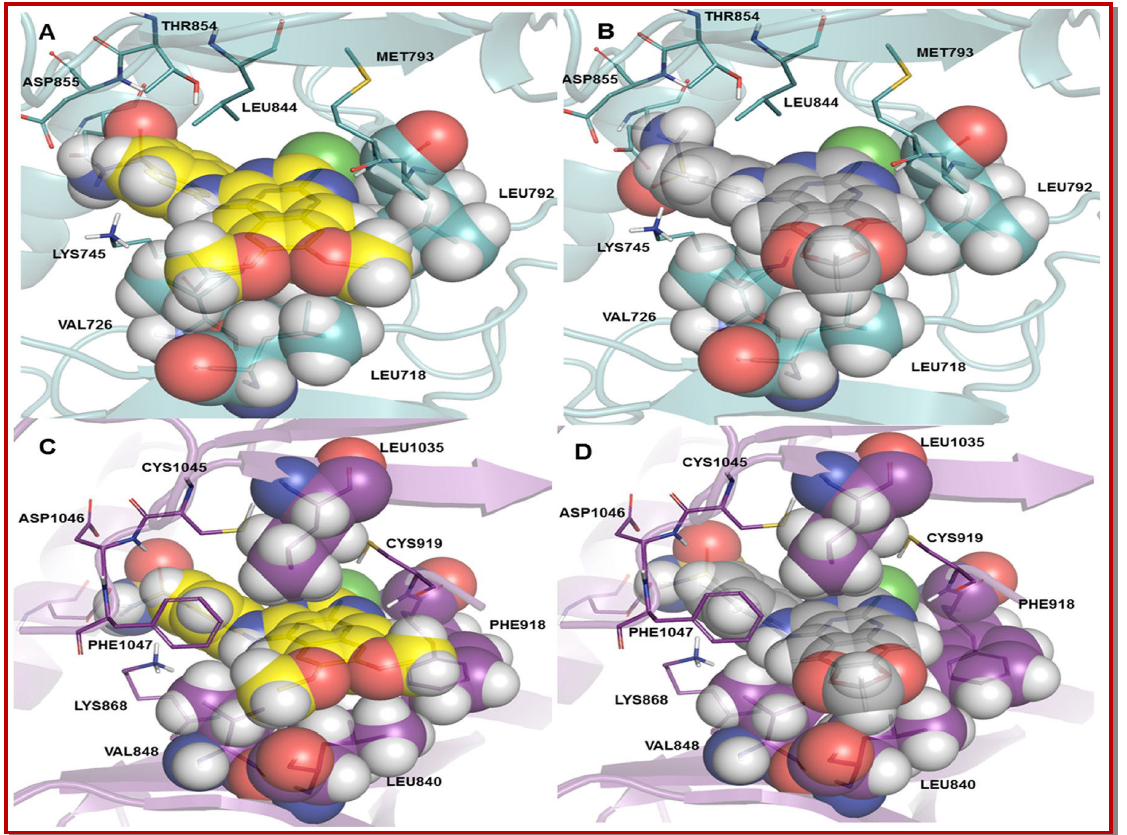
Figure 4: (A) Binding interactions of 6,7-dimethoxy-derivative of quinazoline (yellow) with EGFRwt. (B) Binding interactions of methylenedioxy-derivative of quinazoline (gray) with EGFRwt. (C) Binding interactions of 6,7-dimethoxy-derivative of quinazo- line (yellow) with VEGFR-2. (D) Binding interactions of methylenedioxy-derivative of quinazoline (gray) with VEGFR-2. Docking studies were performed with the GOLD 5.1 program. Apolar hydrogen atoms were omitted to improve clarity. The images were generated with PyMol Software (Barbosa et al.,